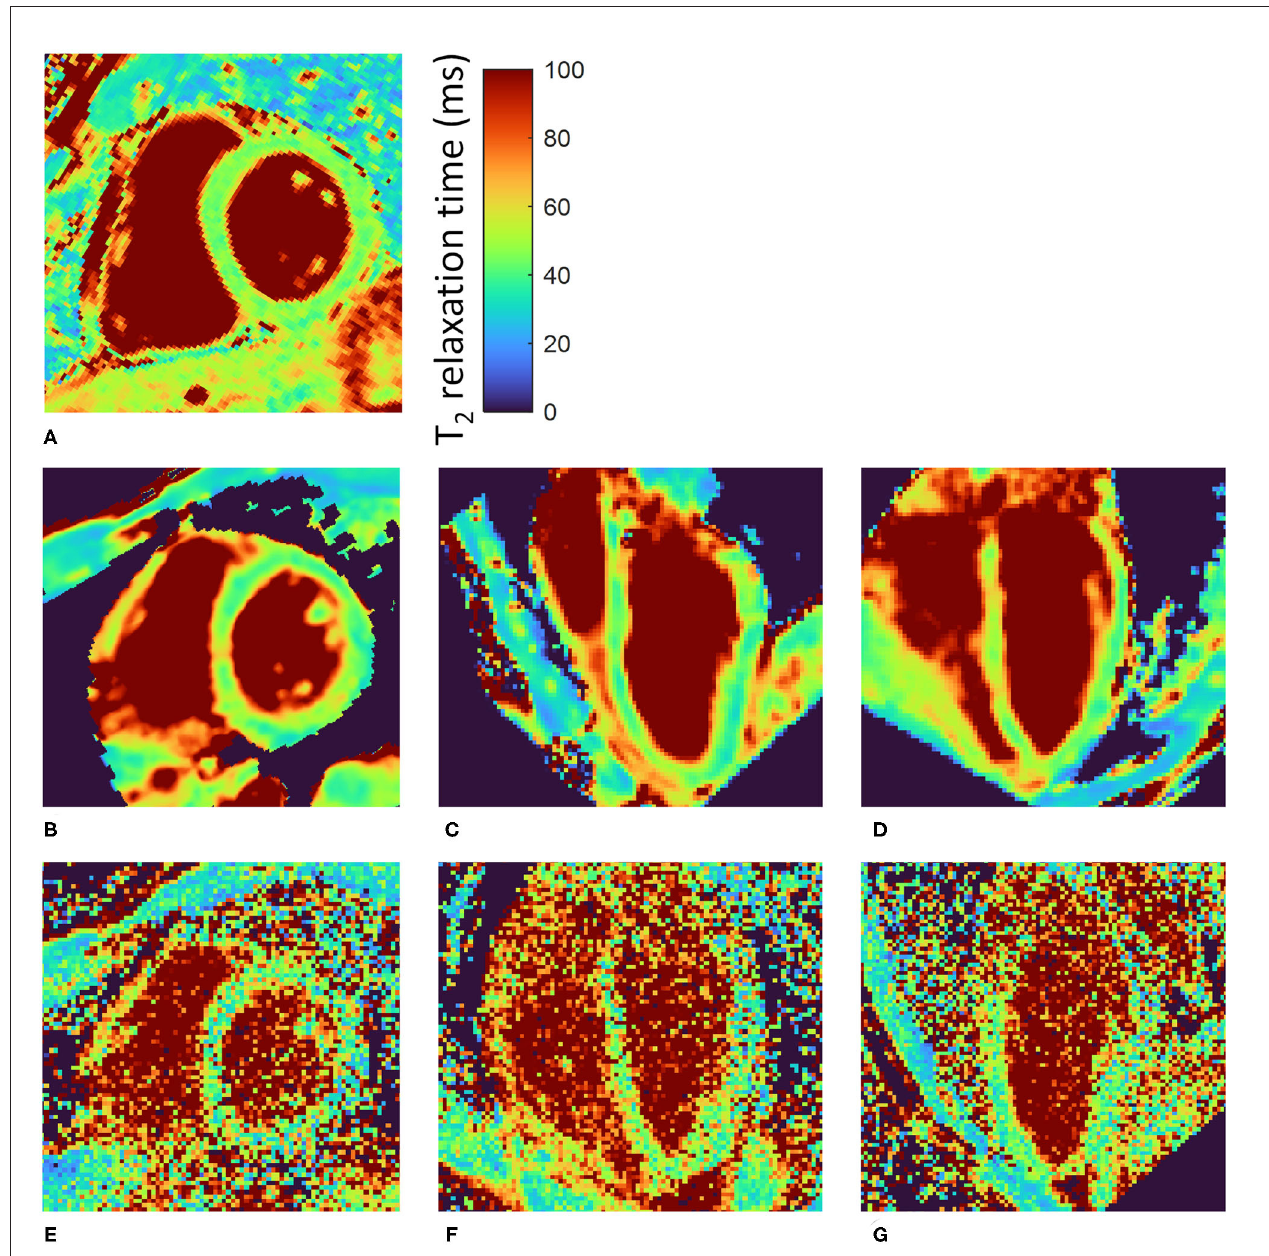
FIGURE 1 | Motion-registered 3D T 2 maps of the heart of a healthy volunteer. (A) Routine T 2 -prepared 2D bSSFP SAX T 2 map. (B) Matching single slice from the motion-registered 3D T 2 map; T 2 values closely match those of the routine map. (C,D) Perpendicular long-axis (LAX) maps from the same 3D datasets as in (B) . (E–G) Three orthogonal slices from a self-navigated reconstruction at approximately the same locations as (B–D) . There is a slight orientation mismatch due to manual rotation of the volumes. The color bar shows the T 2 relaxation time in